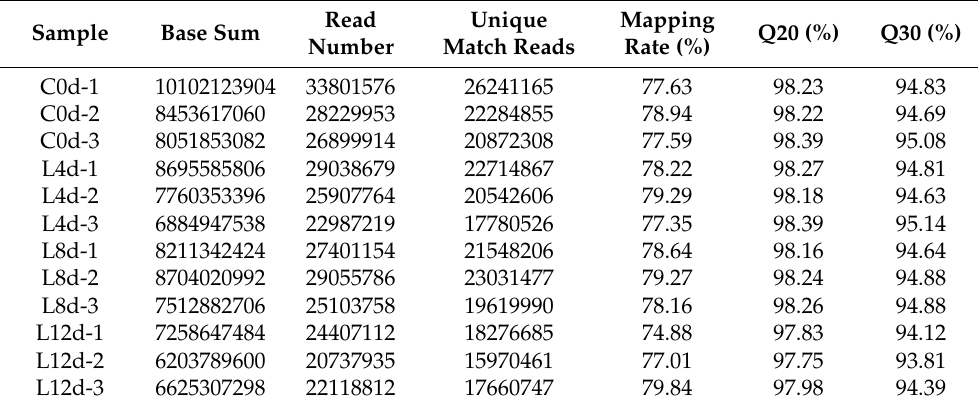
Table 1. Data quality and alignment analysis.